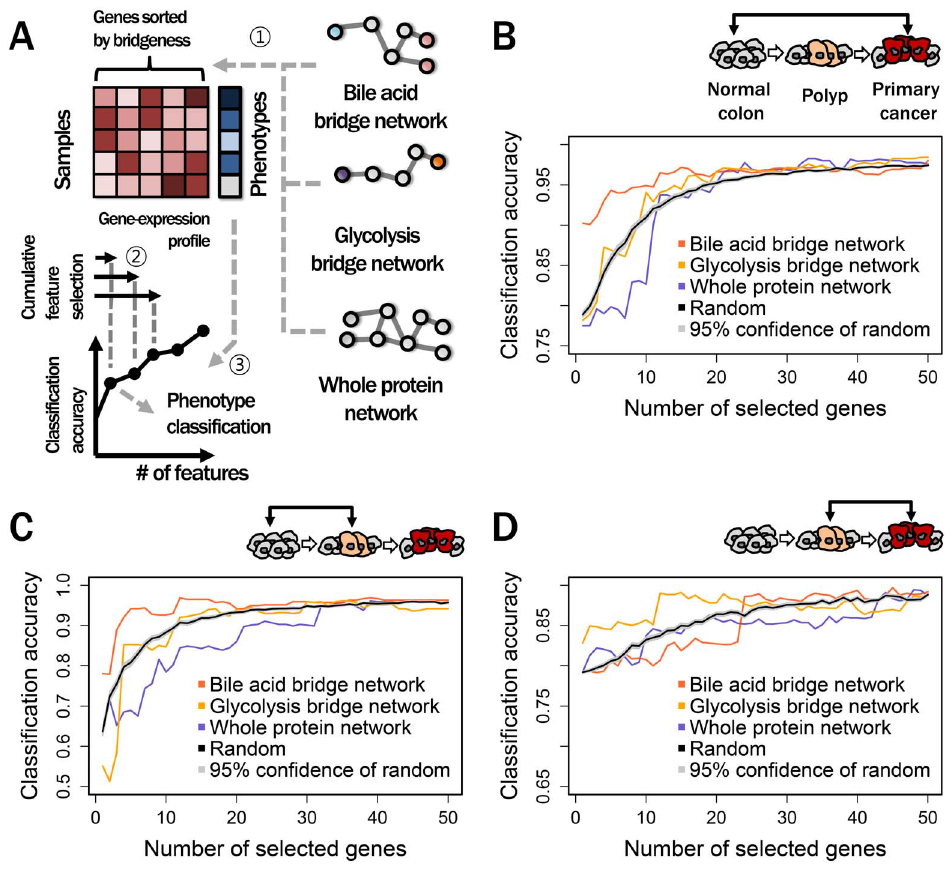
Figure 3. Multivariate analysis of bridge proteins from different networks. ( A ) Overall process of multivariate classifications using features from bridge proteins of different networks. After sorting bridge proteins by their bridgeness ( ), features were extracted cumulatively from top- ranked bridge proteins ( ). Samples were subsequently classified by cumulatively selected features and calculated classification accuracies ( ). ( B ) Accuracies of classifications between normal colon and primary CRC tissues. For classifications, bridge proteins were obtained from (i) a bile acid bridge network (red), (ii) a glycolysis bridge network (yellow) and (iii) an whole protein network (purple). Classification accuracies were also calculated using randomly selected proteins (black) with 95% confidence intervals (gray) on the mean classification accuracies of repeated random selections ( C ) Accuracies of classifications between normal colon and polyp tissues. ( D ) Accuracies of classifications between polyp and primary CRC tissues.